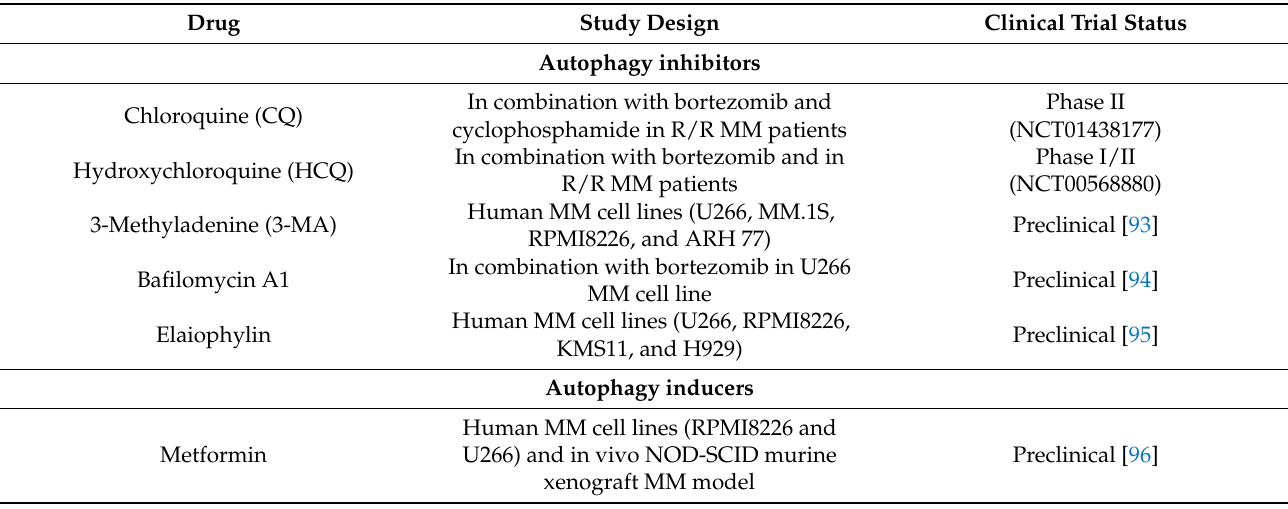
Table 3. Preclinical studies and clinical trials of autophagy inhibitor or inducer alone or in combination with bortezomib in